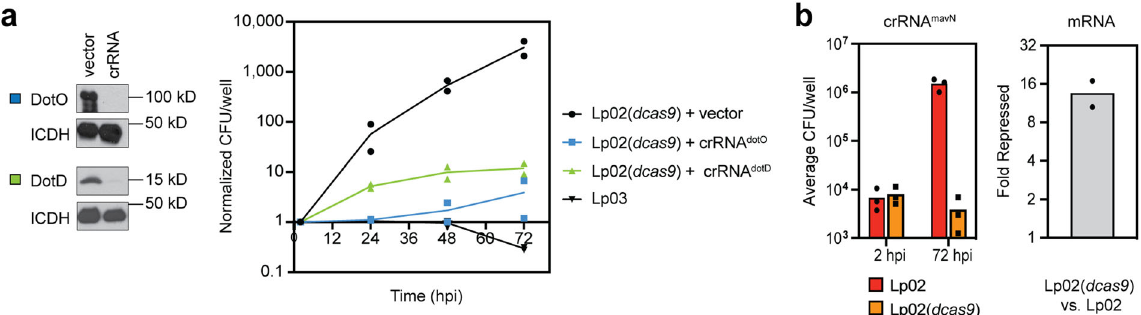
Fig. 5 L. pneumophila CRISPRi is functional during intracellular growth. a Immunoblots con fi rm decreased levels of DotO and DotD in Lp02( dcas9 ) strains expressing crRNA dotO or crRNA dotD . ICDH serves as a loading control. Growth of these strains in U937 macrophages was compared to that of Lp02 ( dcas9 ) bearing an empty vector and the avirulent strain Lp03, with a chromosomal mutation in dotA . Growth is plotted as CFU/well normalized to the CFU at 2 h post infection (hpi). b Growth of Lp02 and Lp02( dcas9 ) expressing crRNA mavN was assayed in U937 macrophages. Growth is given as the average of CFU/well of three experiments at 2 and 72 hpi. mRNA levels of mavN in Lp02( dcas9 ) vs . Lp02 were measured by qPCR. Fold repression was determined using ΔΔ C T